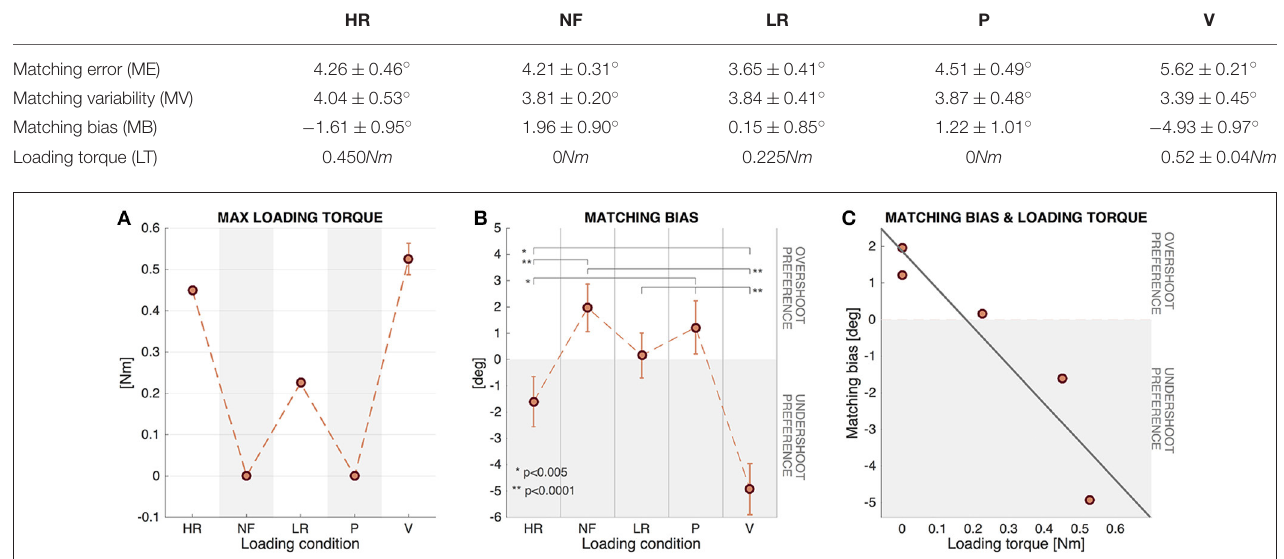
FIGURE 6 | (A) Maximum value of loading torques (LT) experienced during the matching movements. Mean and SE of the 12 participants. (B) Matching Bias in the five different force conditions (Mean and SE of the 12 participants). Positive values indicate tendency for target overshooting and negative values tendency to undershoot. (C) Relationship between Matching Bias and Loading torque for the 12 subjects. Regression line corresponding to the scatter plot of the two